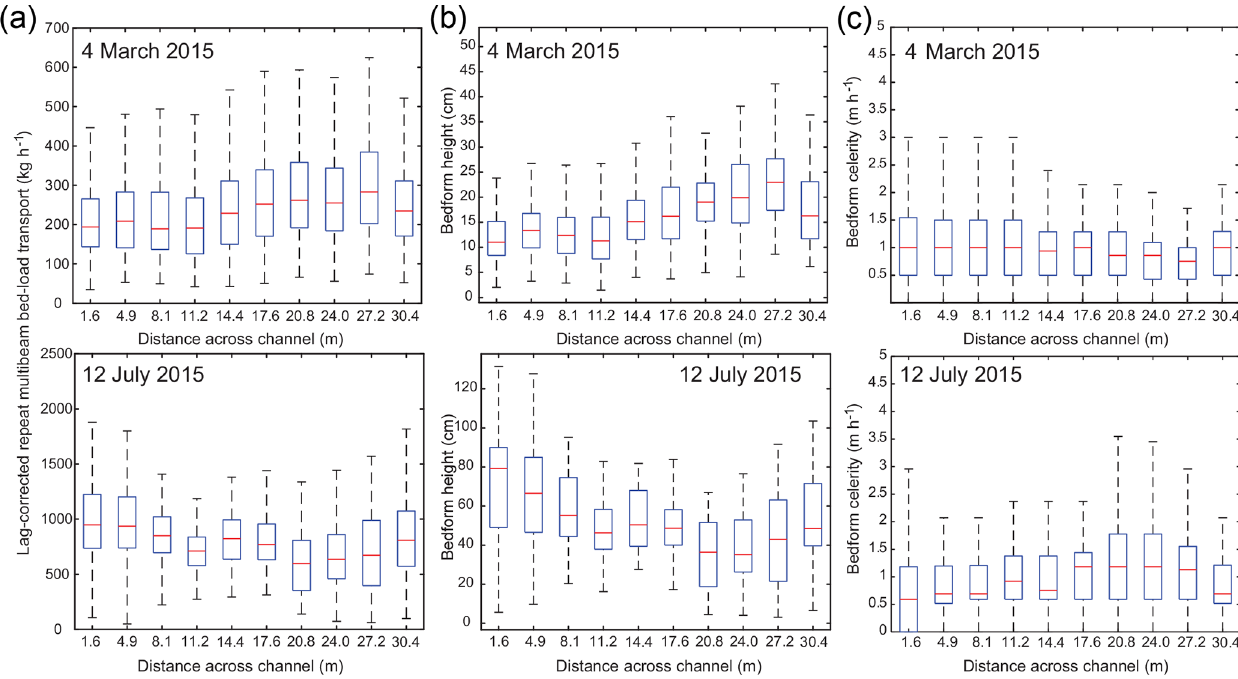
Figure 6. Boxplots of lag-corrected repeat multibeam bed-load transport estimates (a) , bedform heights (b) , and bedform celerities (c) with varying distance across the channel (from river right to river